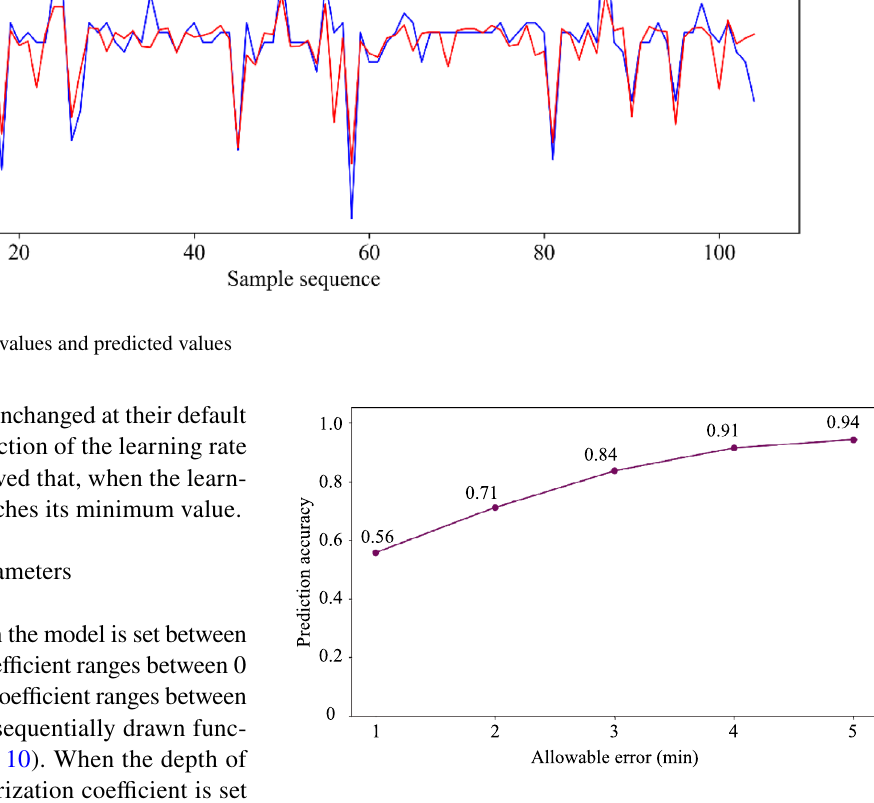
Fig. 12 Model prediction accuracy for different allowable